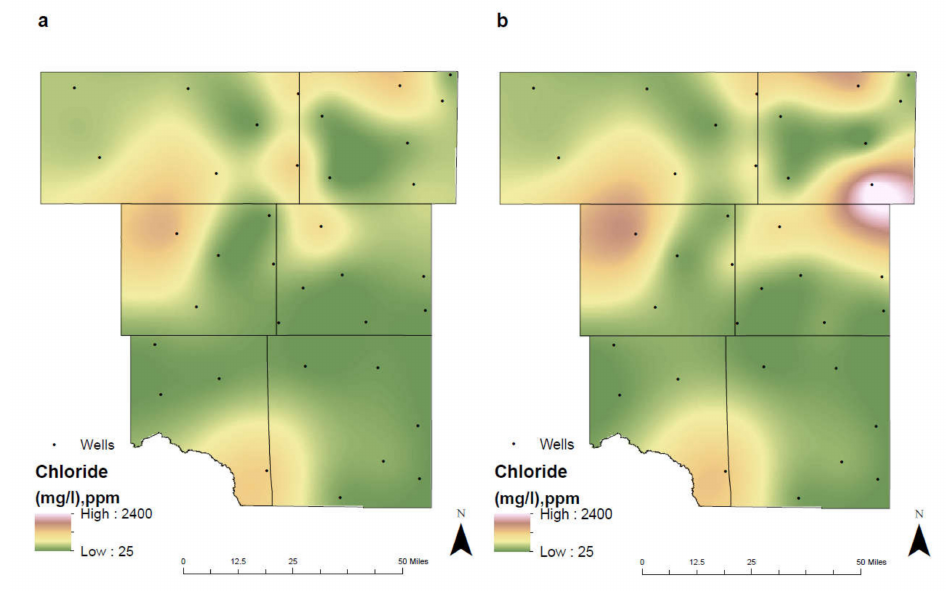
Figure 6. Spatial distribution of chloride in the study area for ( a ) 1992–2005 and ( b )